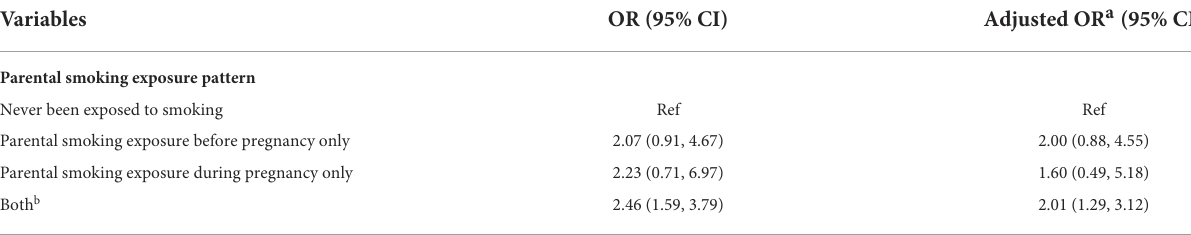
TABLE 3 The associations of different parental smoking exposure patterns before and during pregnancy and offspring ADHD risk.